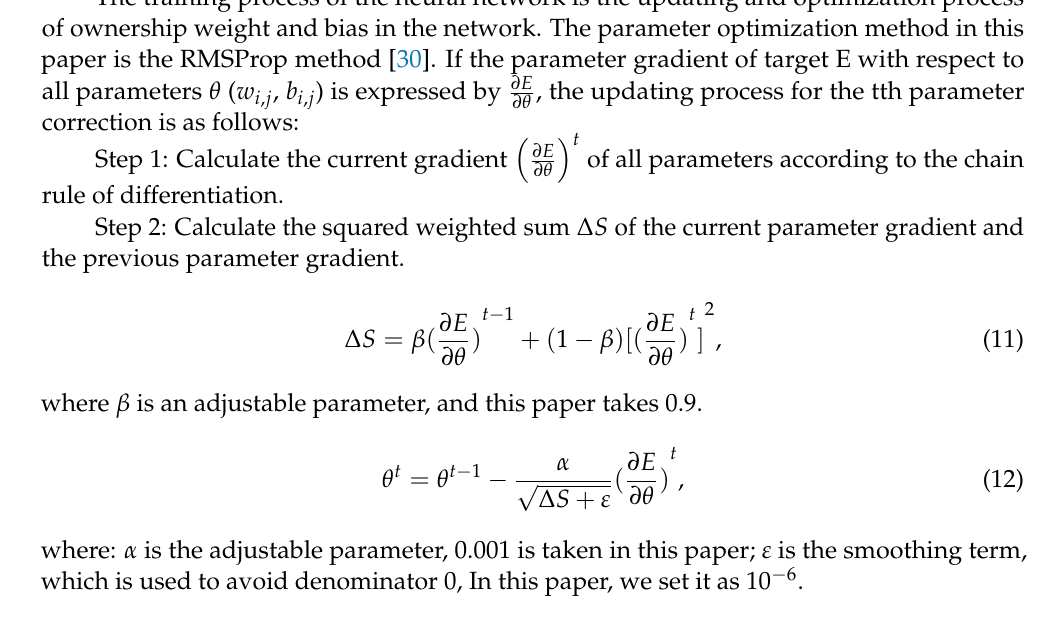
− is the hidden L − neurons in